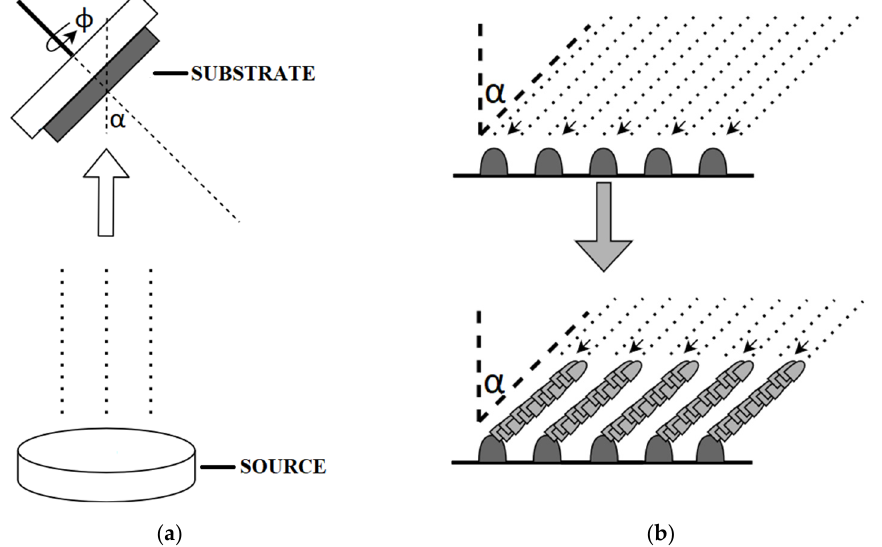
Figure 1. Scheme of the GLAD technique: ( a ) drawing of main process; ( b ) film deposition process on the substrate with shadowing effect.